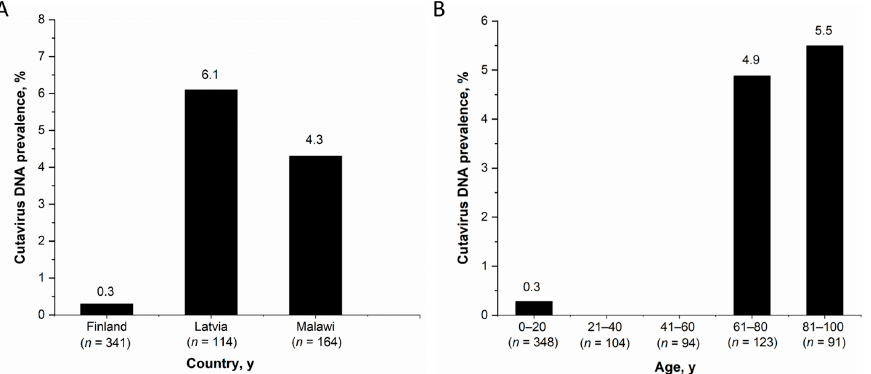
Figure 1. CuV ‐ DNA stool prevalence ( A ) Among children from Finland, Latvia and Malawi, ( B ) Among all patients from Finland by age. ( B ) Among all patients from Finland by Among the respiratory samples, CuV DNA was detected in 2/44 (4.5%) NPAs from children from Latvia but not in any of 272 pediatric nasal swabs from the Leukemia or Tampere cohorts from Finland. The two CuV DNA ‐ positive NPAs from the Latvian co ‐ hort were from children 45 ‐ and 39 ‐ months of age, both with RTI and fever at the time of sampling. The viral loads of the CuV DNA ‐ positive NPA samples were 8.62 ×10 2 and 2.04 × 10 3 copies/mL of NPA respectively (Table 3). No stool samples were available from these two individuals and the corresponding plasma samples were CuV ‐ DNA and ‐ IgG negative. In addition, they were both positive for HBoV1 DNA in NPA, but not in serum, and one of the children was also positive for human rhinovirus RNA. The 91 ‐ nt long CuV amplicons from all CuV DNA ‐ positive samples in the current study, had 1 to 5 nucleotide mismatches in the non ‐ primer ‐ binding region, compared with the CuV sequence NC_039050.1, serving as positive control in qPCR (Appendix Figure S1).